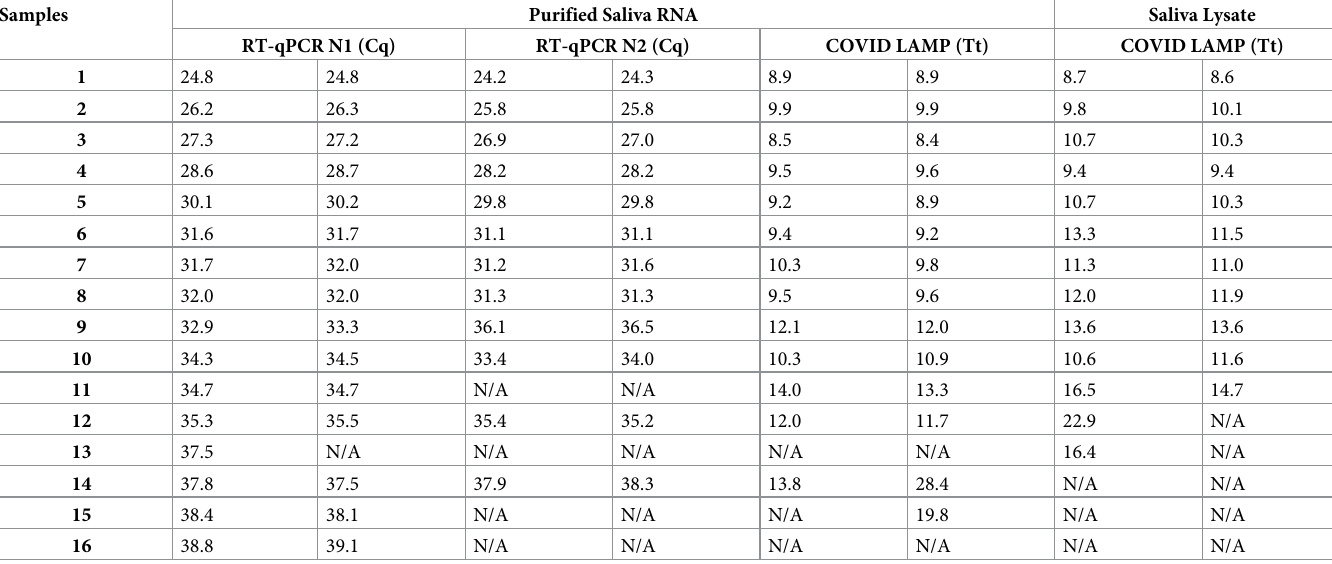
16 saliva samples containing a range of viral load were tested in RT-qPCR (N1 and N2 targets) and RT-LAMP(SARS-CoV-2). For RT-LAMP, both saliva lysate and purified RNA were used as input, whereas RT-qPCR was performed using only purified RNA. Cq values for RT-qPCR and Tt for RT-LAMP are shown. No amplification is denoted N/A.